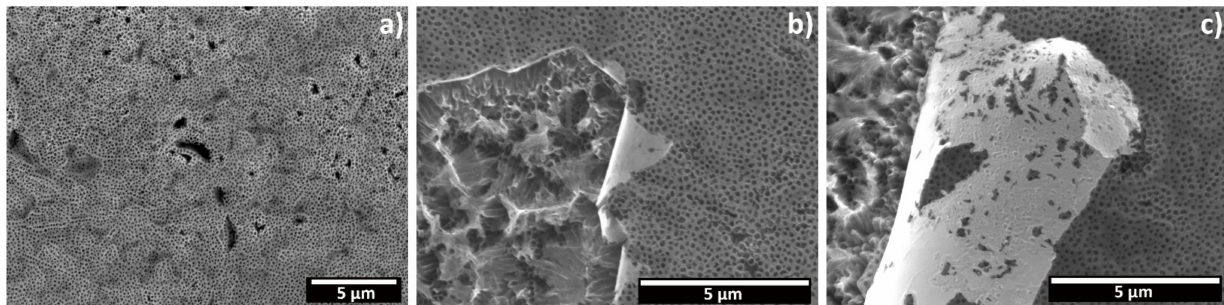
Figure 6. FESEM micrographs depicting a top view of the oxide layer produced on CP-Ti through electrochemical anodization at 80 V for 1 h: ( a ) view of the porous compact oxide; ( b , c ) detail of the detachment of the initiation layer, revealing the nanograss structure